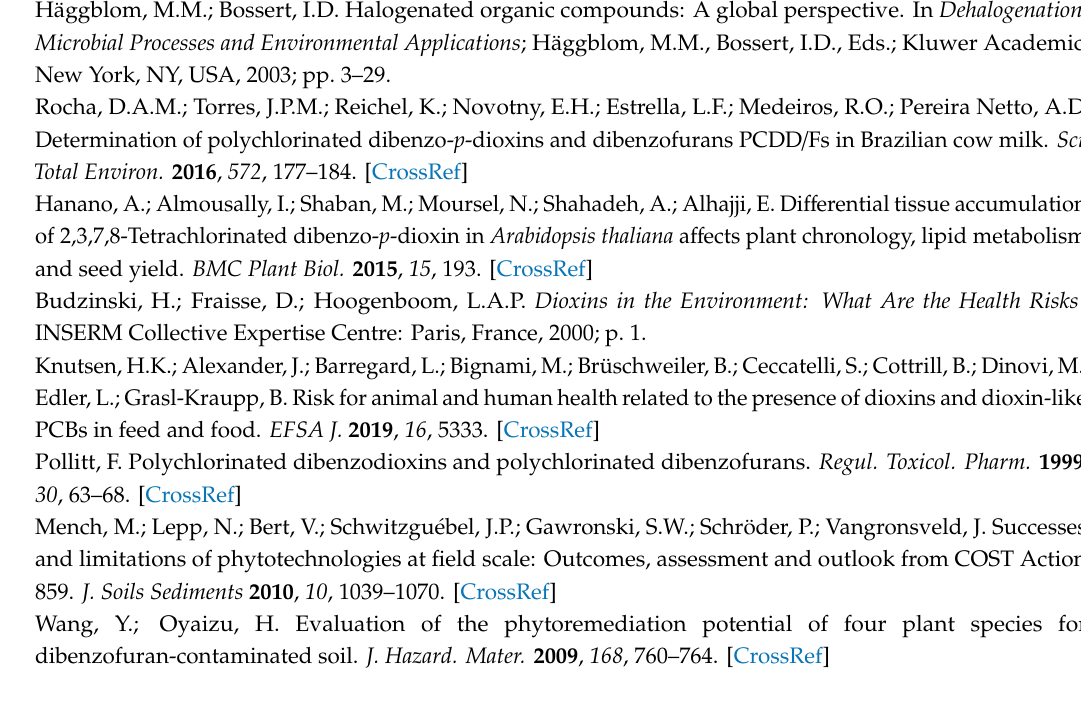
Figure S1: Repartition (%) of PCDD / F in the A + Fm + RW1 + Rh + µ b condition after 6 months of culture in microcosms, Figure S2: Principal coordinates analysis (PCoA) of (a) Bacteria, (b) Fungi, and (c) Total Archaeal community. Red color for the control non-vegetated soil, blue color for A + Fm + RW1 + Rh + µ b condition, Table S1: Summary